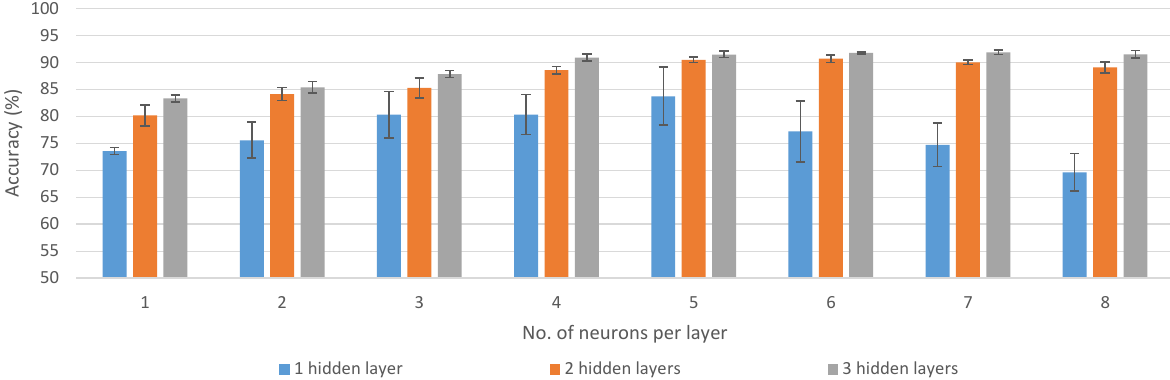
Figure 3. Average of the results obtained with the Kalman dataset over the different cross-validation folds for each of the analyzed